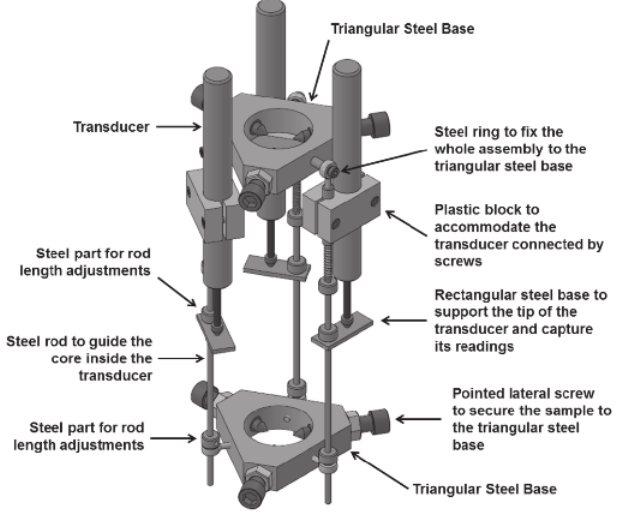
the apparatus used in test method 3